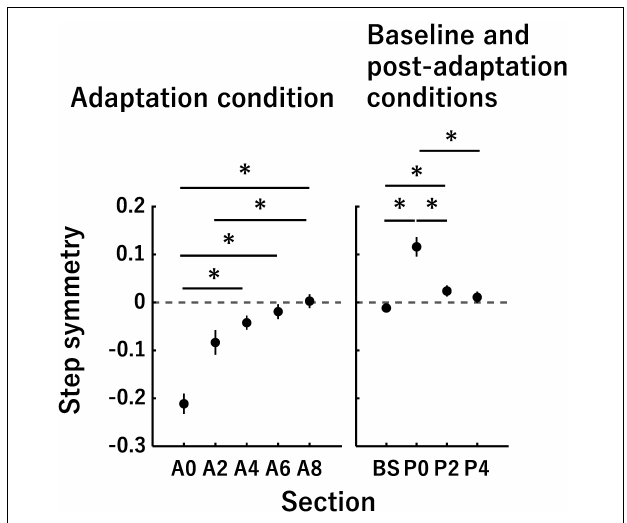
FIGURE 2 | Time-series changes in the step symmetry. The vertical axis indicates the step symmetry, and the horizontal axis indicates the sections in each panel. A value of 0 in the vertical axis (dotted lines) indicates that the step lengths of the slow leg and fast leg are equal (i.e., symmetry). The panels represent time-series changes in the step symmetry in the adaptation condition (left panel) as well as the baseline and post-adaptation conditions (right panel). Error bars indicate mean ± SE. ∗ P < 0.0051 (adaptation condition) and 0.0085 (baseline and post-adaptation